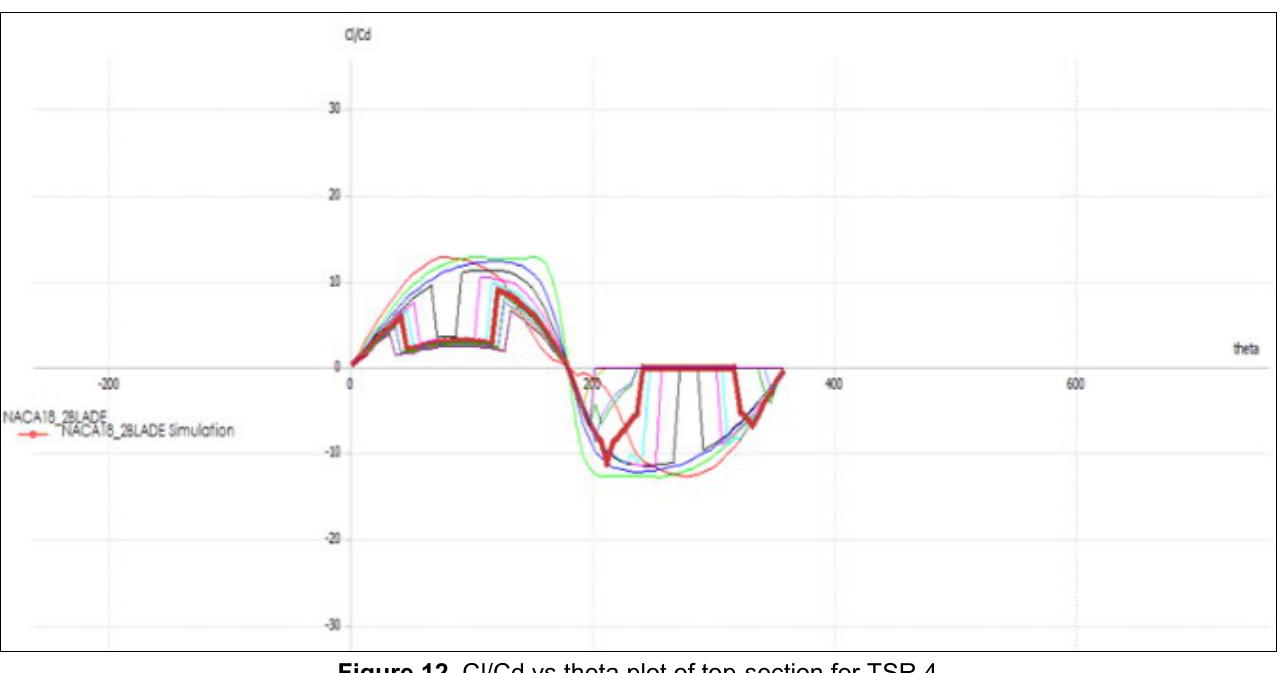
Figure 12. Cl/Cd vs theta plot of top-section for TSR 4